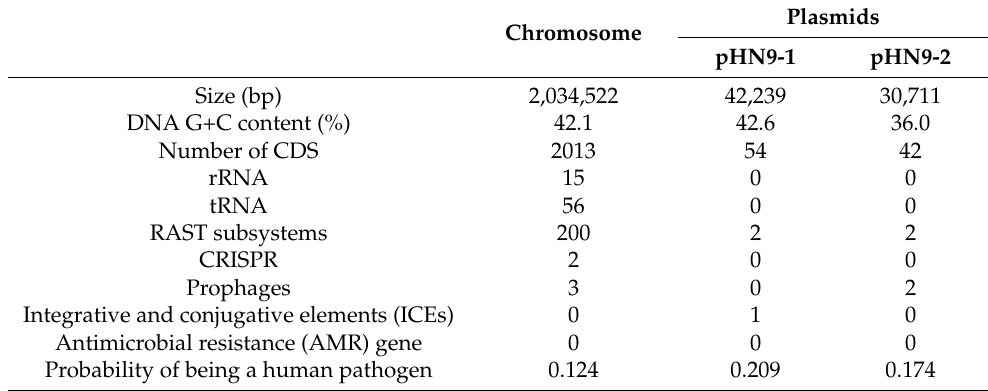
Table 1. Genomic features of P. acidilactici HN9.